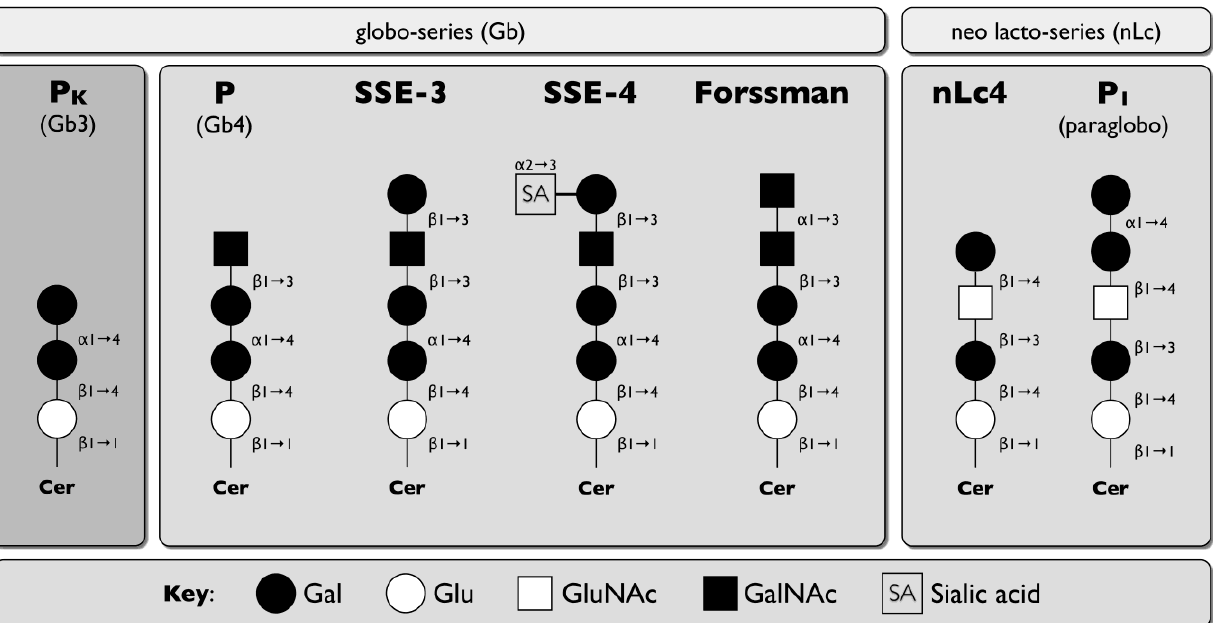
parvovirus B19. Schematic representation of nLC and Gb attachment receptors in comparison to the non-binding globoside Gb3. Abbreviations: Glu: glucose, Gal: galactose, GluNAc: N-acetylglucosamine, GalNAc: N-acetylgalactosamine, Cer: ceramide, R: